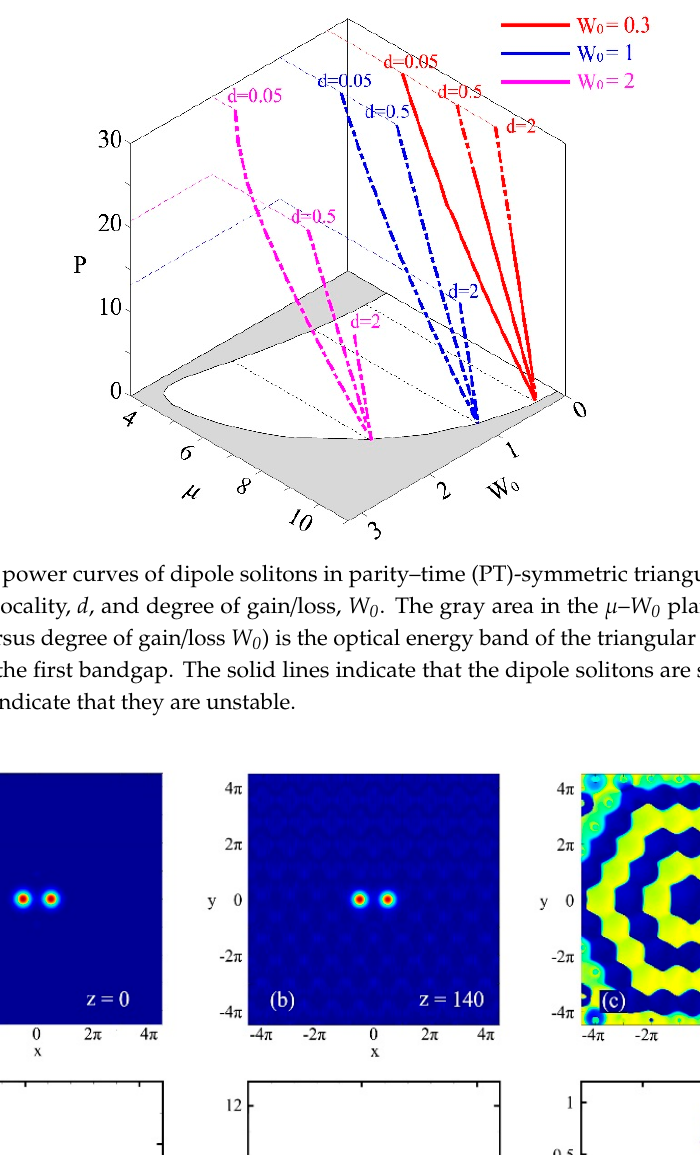
Figure 2. The power curves of dipole solitons in parity–time (PT)-symmetric triangular lattices with different nonlocality, d , and degree of gain/loss, W 0 . The gray area in the μ – W 0 plane (propagation constant μ versus degree of gain/loss W 0 ) is the optical energy band of the triangular lattices, thus the white area is the first bandgap. The solid lines indicate that the dipole solitons are stable, while the dashed lines indicate that they are unstable.